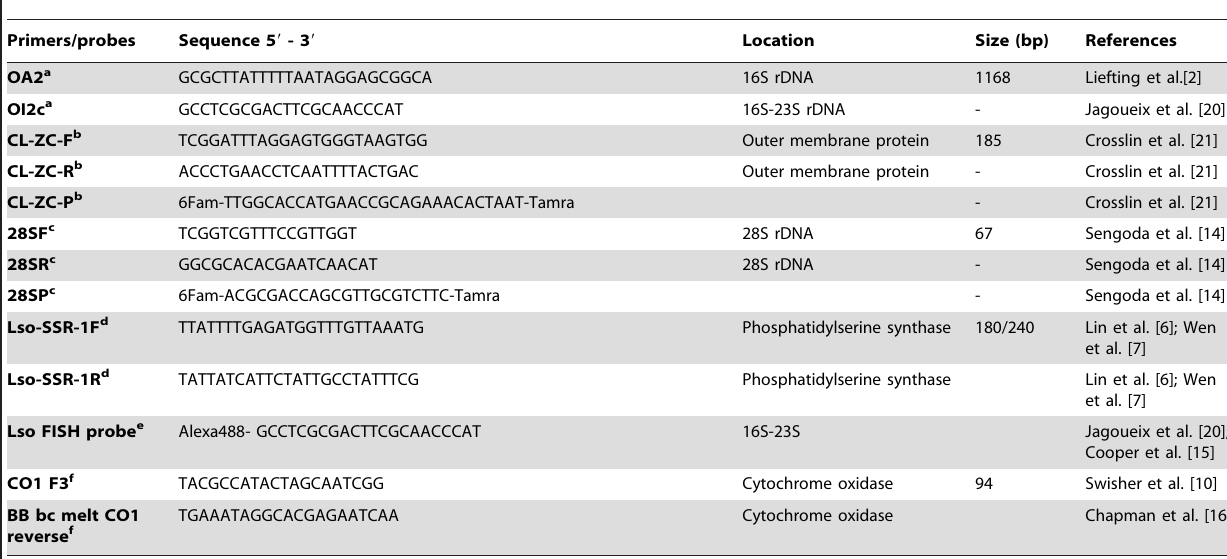
Table 1. Primers and probes used in this